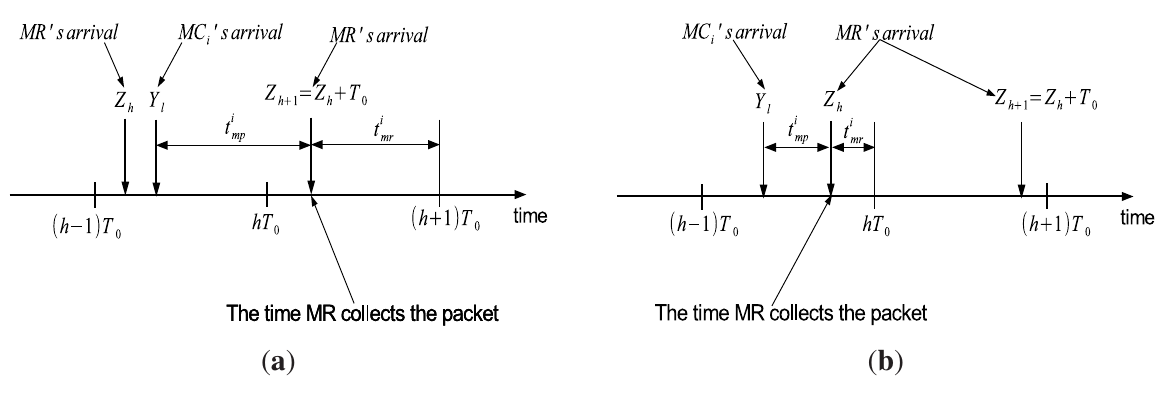
Figure 6. Estimating the waiting time of a packet in the MP. ( a ) Case 1: Z Z ≥ Y h l